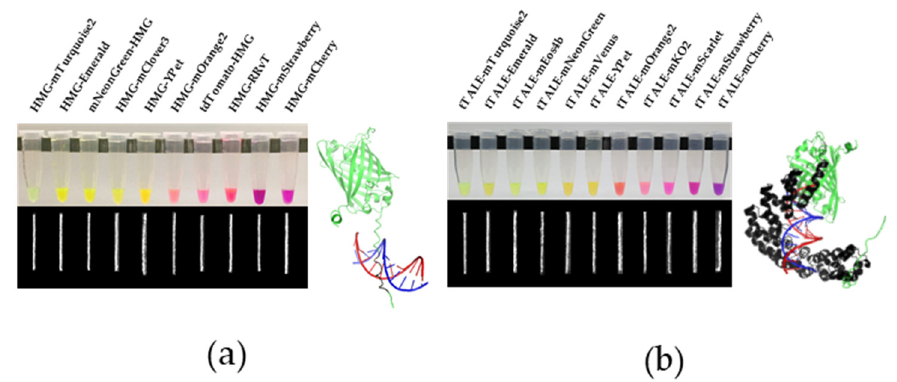
Figure 1. Expressed FP-DBPs in test tubes and their stained DNA images. ( a ) HMG-FP/FP-HMG ( b ) tTALE-FP. FP-DBP stained λ phage DNA images were given below. Illustrations of FP-DBP binding to DNA were shown for comparison of the size of DBPs. HMG-Emerald and tTALE-Emerald structures were modeled through AlphaFold 2.1.0 (DeepMind, London, UK) [36]. DNA-binding protein motifs were colored black and were aligned to DNA by using PDB 2EZD ( a ) PDB 4OTO ( b ) in the software PyMOL. Table 1. List of FPs selected from FPbase.org (accessed on 18 July 2022).